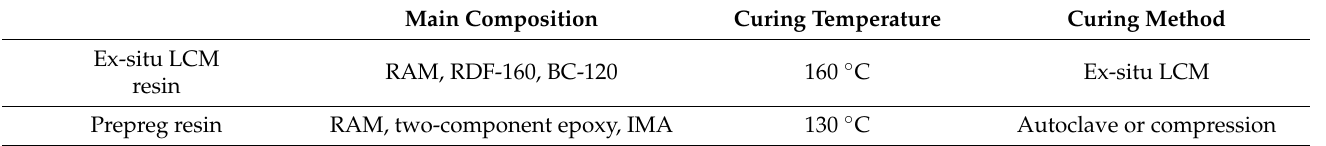
Table 1. Bio-sourced epoxy system studied.